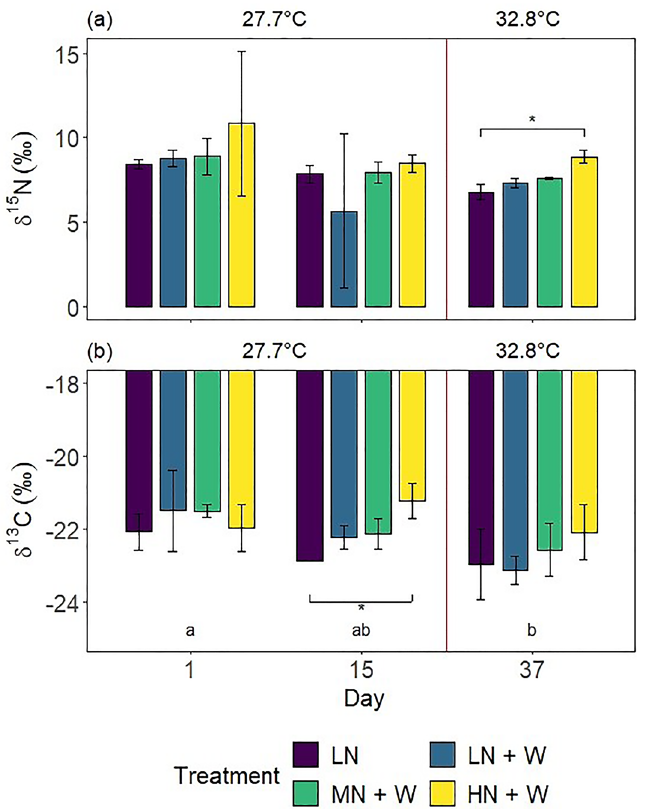
Figure 6. ( a ) Nitrogen and ( b ) carbon stable isotope ratios of Xenia umbellata colonies from control tanks with low nitrate (LN, ~ 0.6 μM) and three treatments: LN + W = low nitrate (~ 0.6 μM) + warming from day 17; MN + W = medium nitrate eutrophication (~ 6 μM) + warming from day 17; HN + W = high nitrate eutrophication (~ 37 μM) + warming from day 17. Error bars represent standard deviations of three replicates, with exceptions of two replicates for controls (LN) on day 15 ( b ) and the LN + W treatment on day 37 ( a & b ). Temperatures represent mean temperatures of the respective days, excluding controls. Different letters in ( b ) indicate significant differences between days (pwc, Bonferroni adjustment, t -test, p < 0.05). Asterisks indicate significant differences between treatments within days (pwc, Bonferroni adjustment, ( a ) Dunn’s test, ( b ) t -test, * = p <